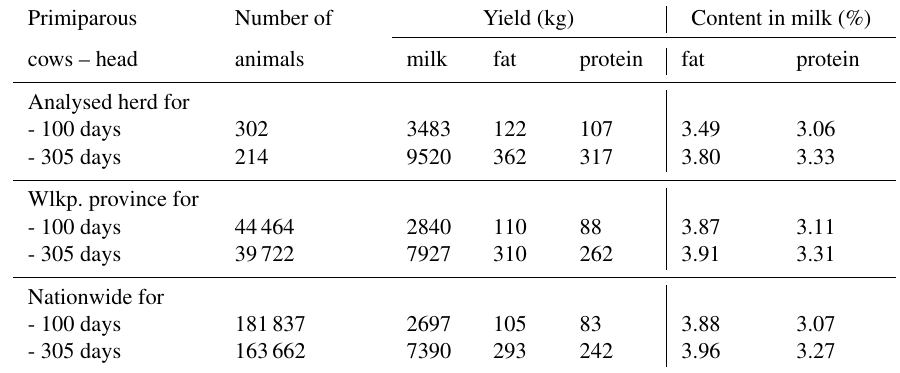
Table 6. Yield of primiparous cows in the analysed herd in the province of Wielkopolskie and nationwide in